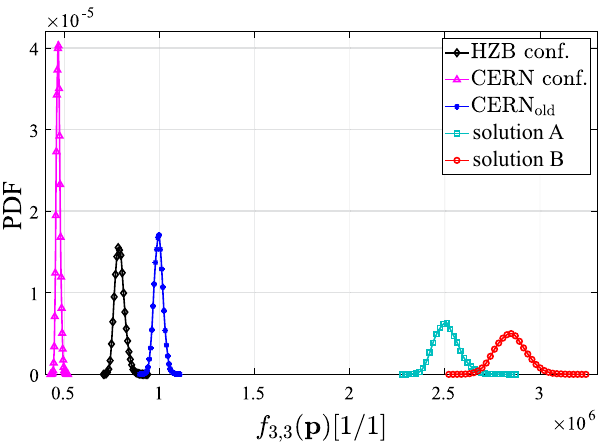
FIG. 12. Probabilistic density function for the dimensionless factor representing the losses on the normal-conducting flange.